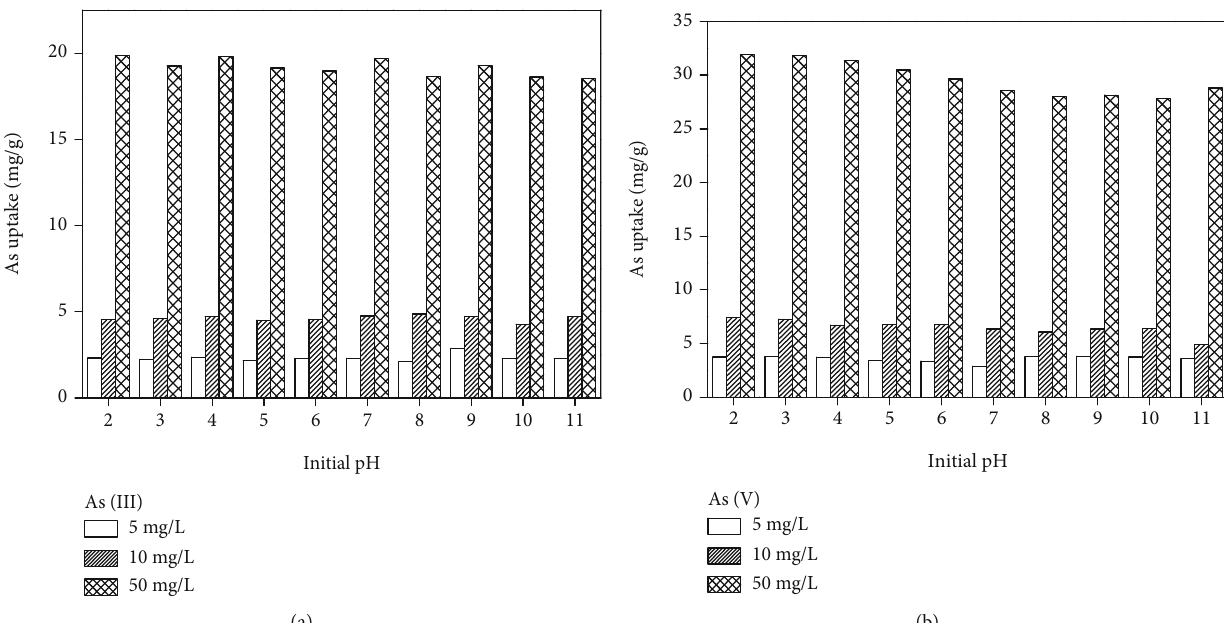
Figure 6: In fl uence of solution pH on As adsorption capacities on Fe/Mn-C-LDH.